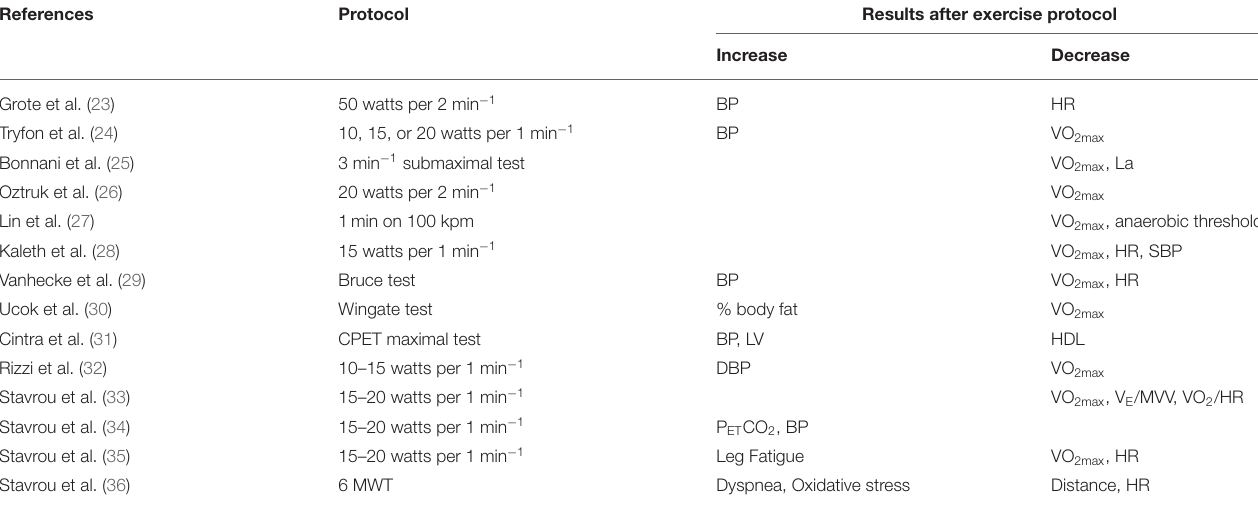
TABLE 2 | Acute responses to exercise in patients with